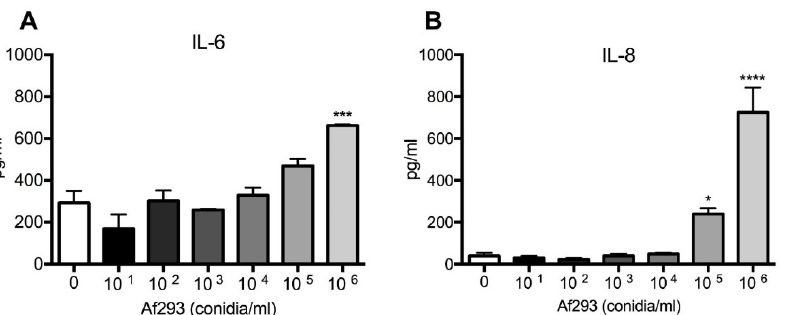
Figure 1. A. fumigatus conidia induce IL-6 and IL-8 production in a dose-dependent manner. A fumigatus conidia significantly induced ( A ) IL-6 at 10 6 and ( B ) IL-8 at 10 6 and 10 5 conidia/mL com- pared with the unexposed control. Data represent mean +/ − SEM analysed by one-way ANOVA with Bonferroni multiple comparison test. **** p < 0.0001; *** p < 0.001; * p < 0.05 compared with the